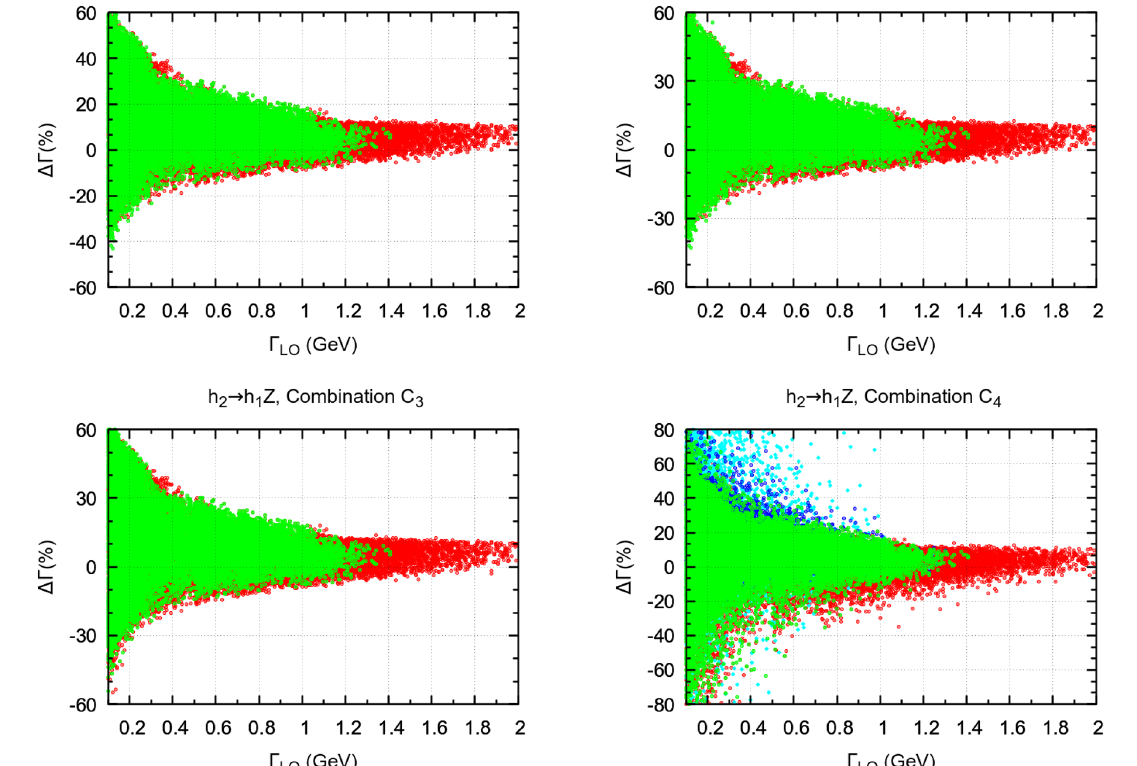
Figure 4. ∆Γ h in percentage as a function of Γ LO , for the combinations C 1 (top left), C 2 h 2 → h 1 Z 2 → h 1 Z (top right), C 3 (down left) and C 4 (down right). Only the interval 0 . 1 GeV < Γ LO < 2 GeV is shown. The color conventions for C 1 , C 2 and C 3 are those of figure 1, whereas for C 4 are those of figure 3. Open